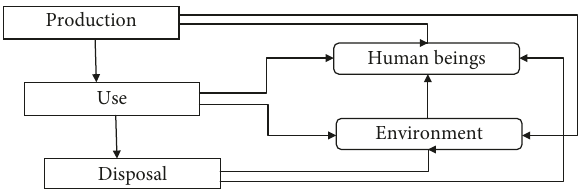
Figure 4: PFAA distribution route dependency diagram